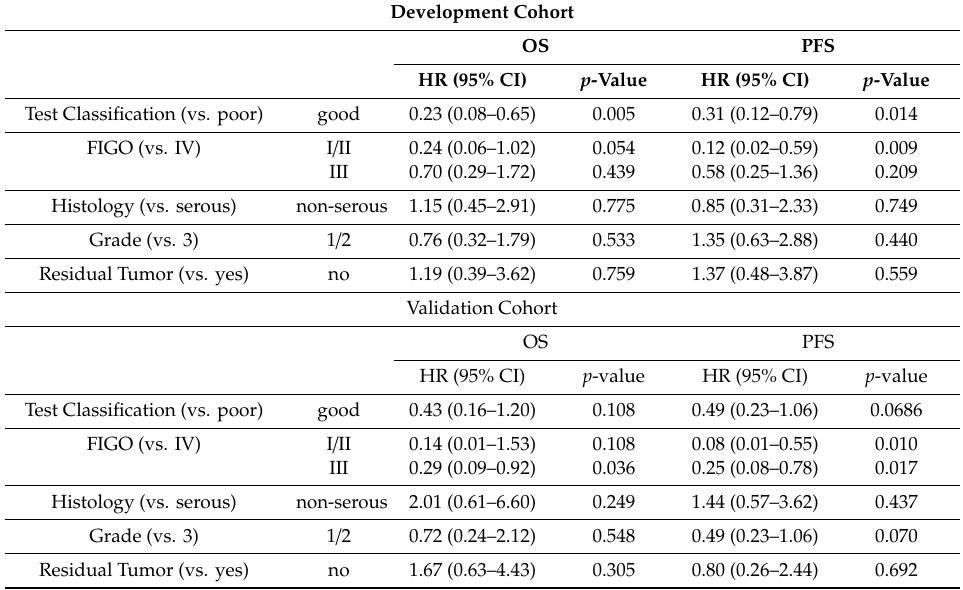
Table 2. Multivariate analysis of overall survival (OS) and progression-free survival (PFS) for younger patients in the DC and in the